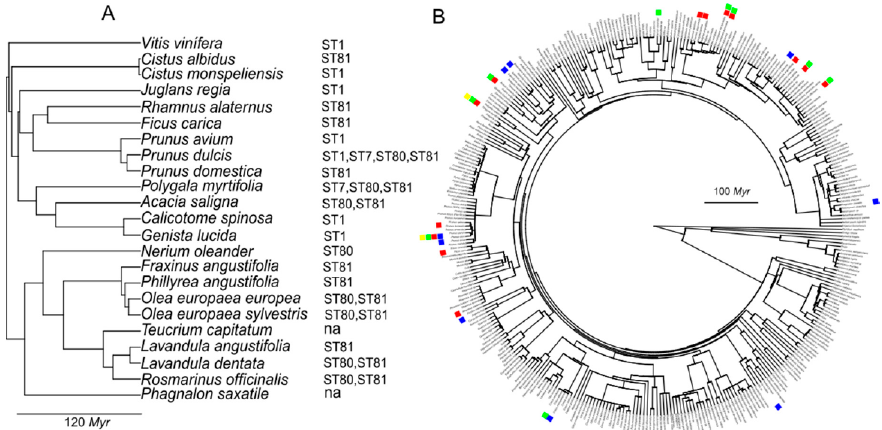
Figure 5. Phylogenetic signal in host range of Xf different STs (clonal lineages) detected in the Balearic Islands between October 2016 and February 2020. ( A ) Phylogenetic distances of Xf hosts. Each of the ST shares hosts that evolutionarily diverged for > 100Myr (million years). ( B ) Phylogenetic tree including all plant species ( n = 348) analyzed for Xf until February 2020. Blue square, ST1; red square, ST81; green square, ST80; and yellow square,